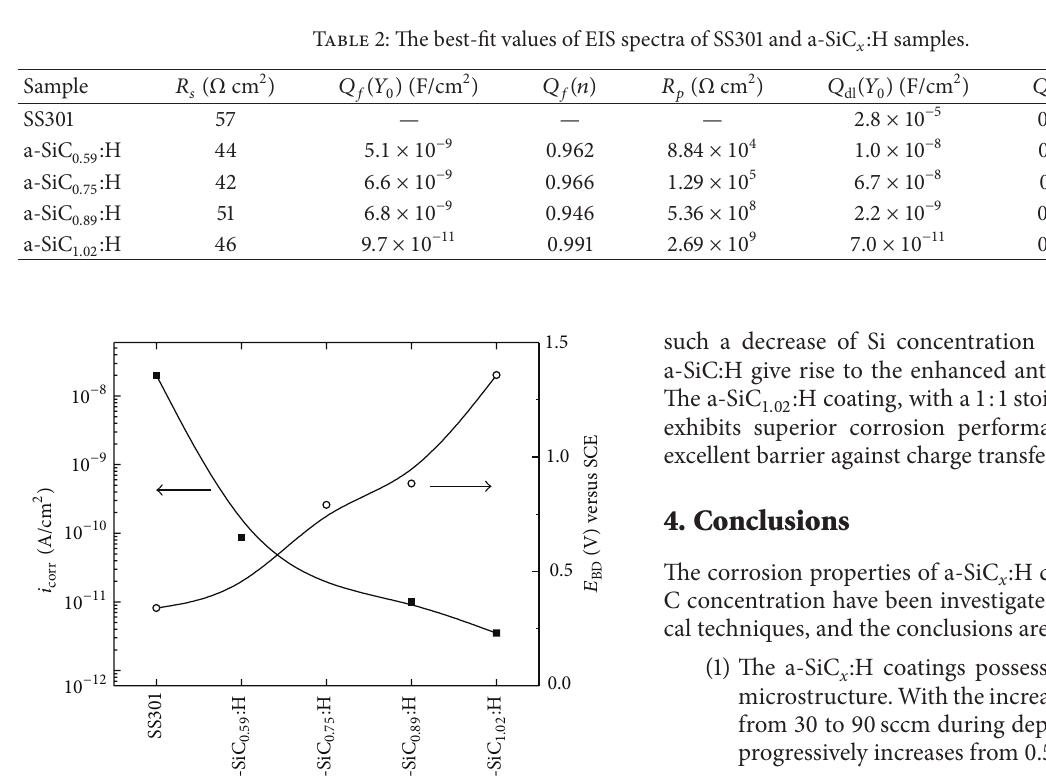
:H coatings and SS301 substrate. x